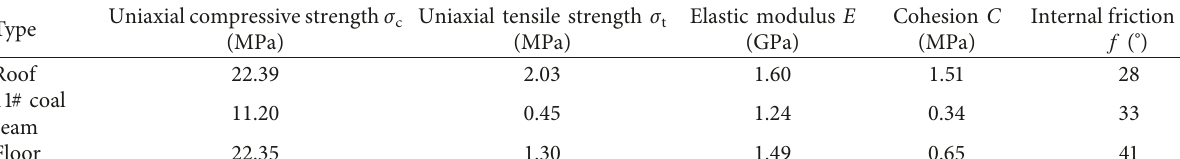
Table 3: Physical and mechanical properties of rock and coal samples.